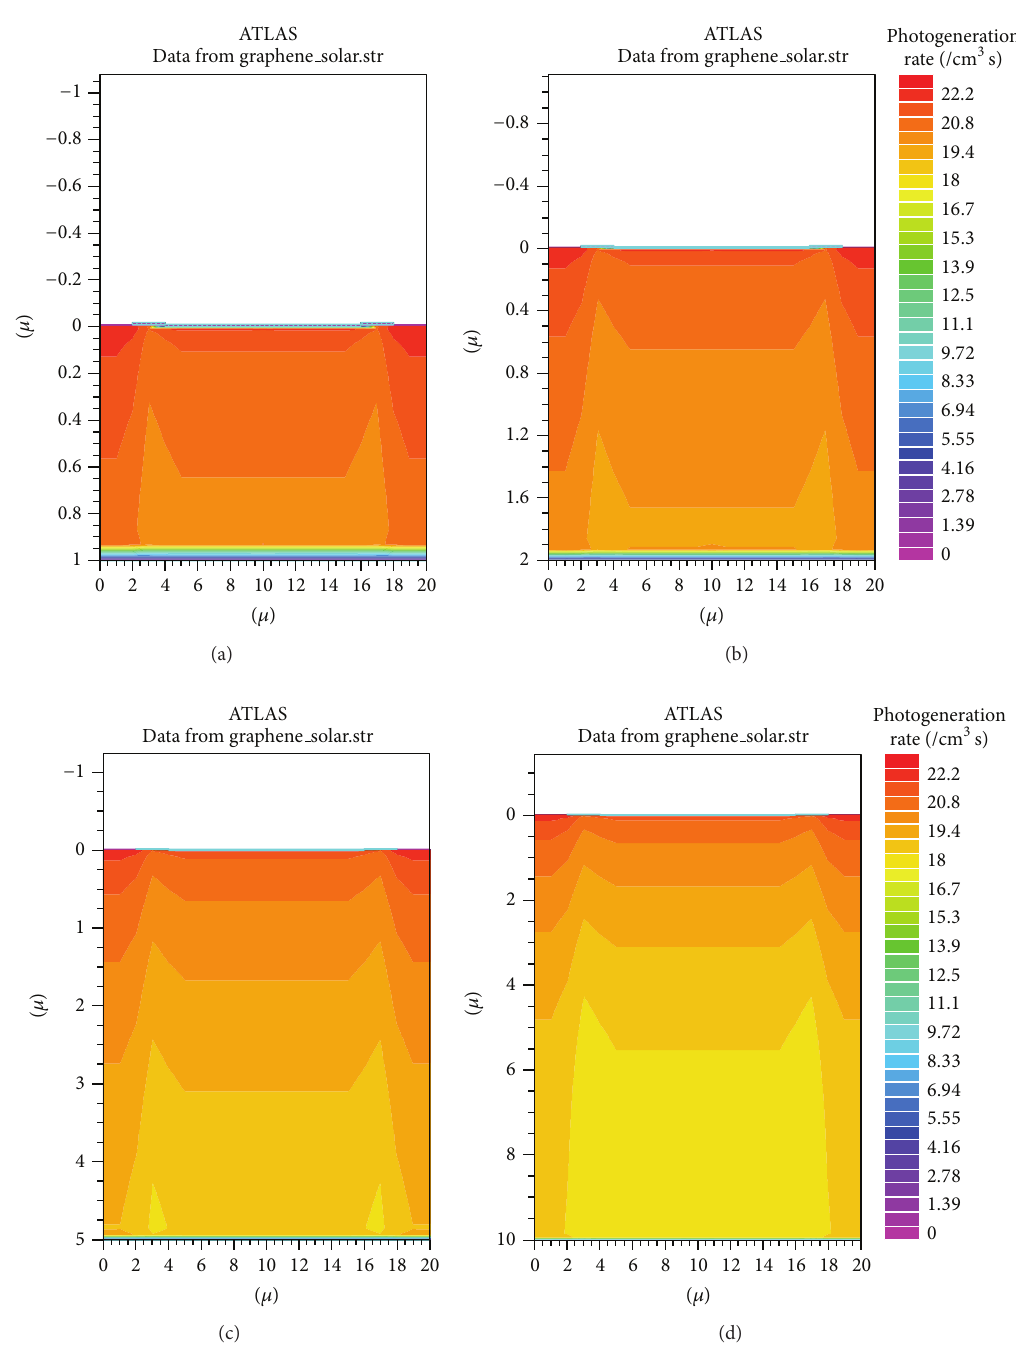
Figure 3: Photogeneration rate of graphene GaAs solar cell under AM1.5 illumination versus substrate thickness: (a) 1 𝜇 m, (b) 2 𝜇 m, (c) 5 𝜇 m, and (d) 10 𝜇